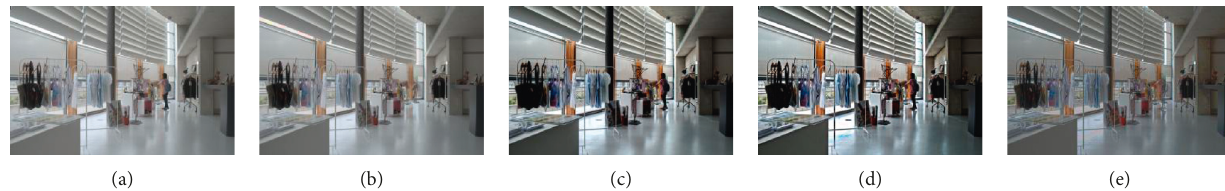
Figure 5: Comparison results on “Shop2” with (a) the proposed method; (b) Oh et al. [26]; (c) Hu et al. [18]; (d) Ma et al. [32]; (e) Photoshop cs6. Table 1: Performance comparison for the proposed method and three state-of-the-art methods using the HIGRADE index. Image sequence